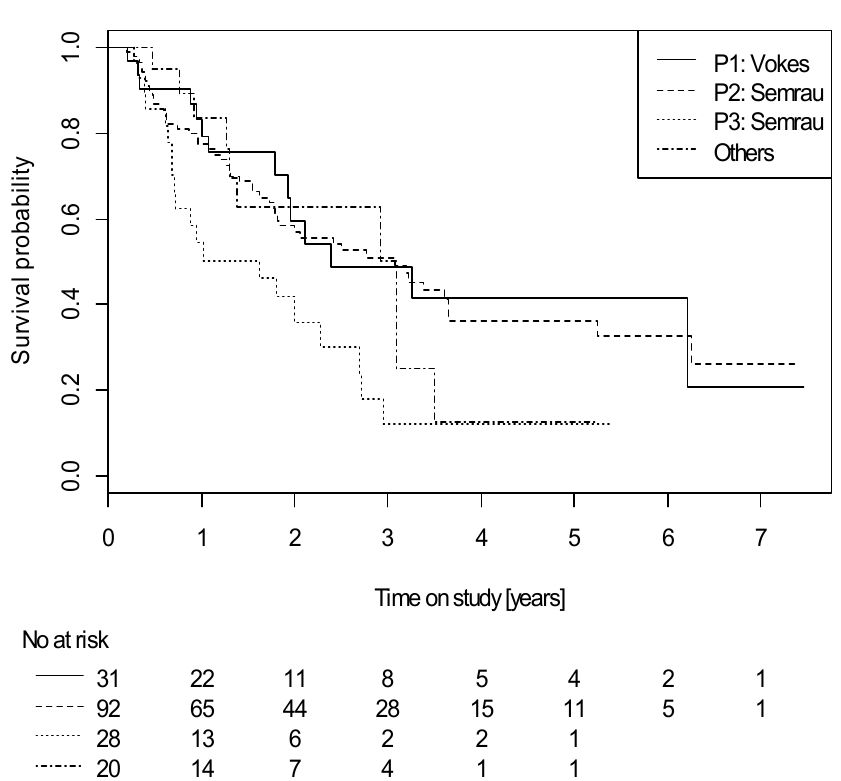
Figure 1. Overall survival according to different chemotherapy protocols.